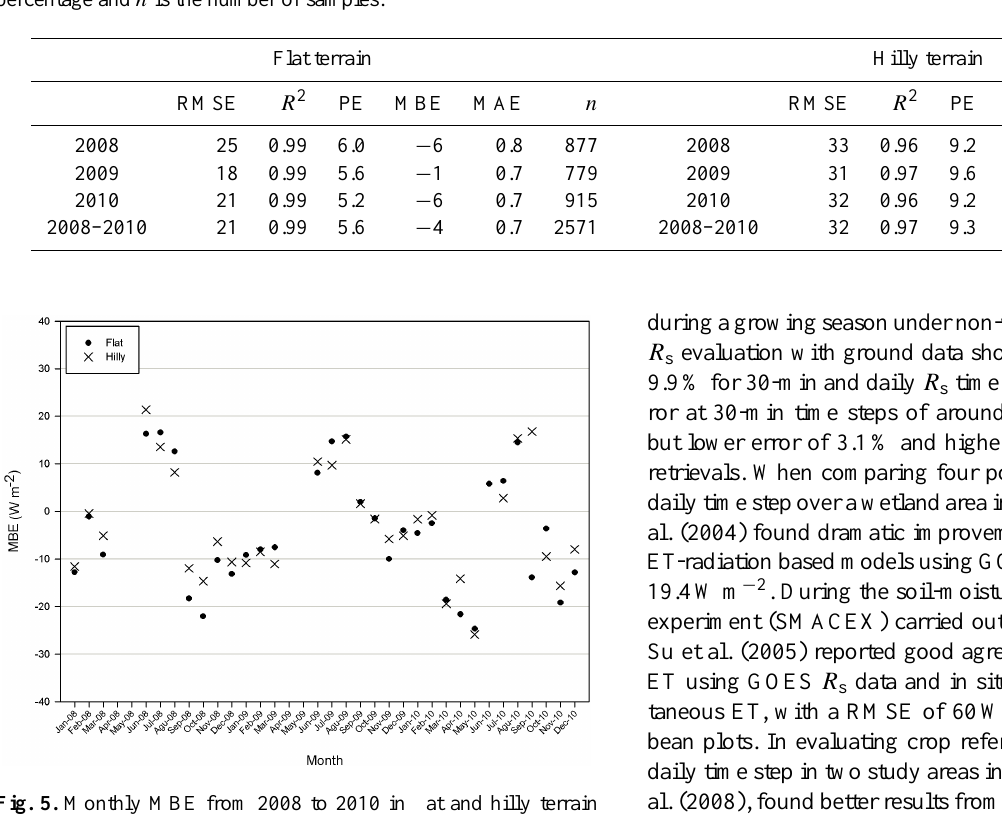
Table 5. Monthly solar radiation error and accuracy statistics for 2008 to 2010 by terrain class. RMSE, MBE and MAE in Wm − 2 , PE in percentage and n is the number of samples.